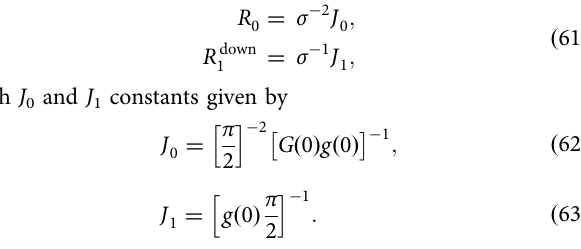
numerical solution of Eq. (59) reveals the following picture: for low values of σ , only the incoherent solution R exists. At a positive value of σ , two solutions of Eq. (59) appear at